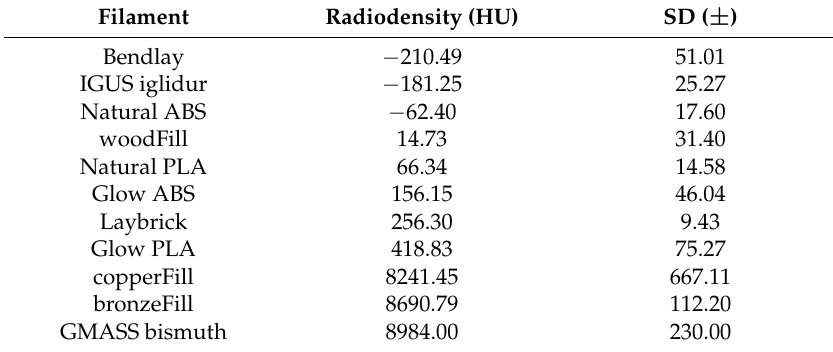
Table 1. Radiodensities of 3D-printed filaments with standard deviations (SD). Filaments were imaged with a preclinical CT scanner and the data subsequently analyzed for HU